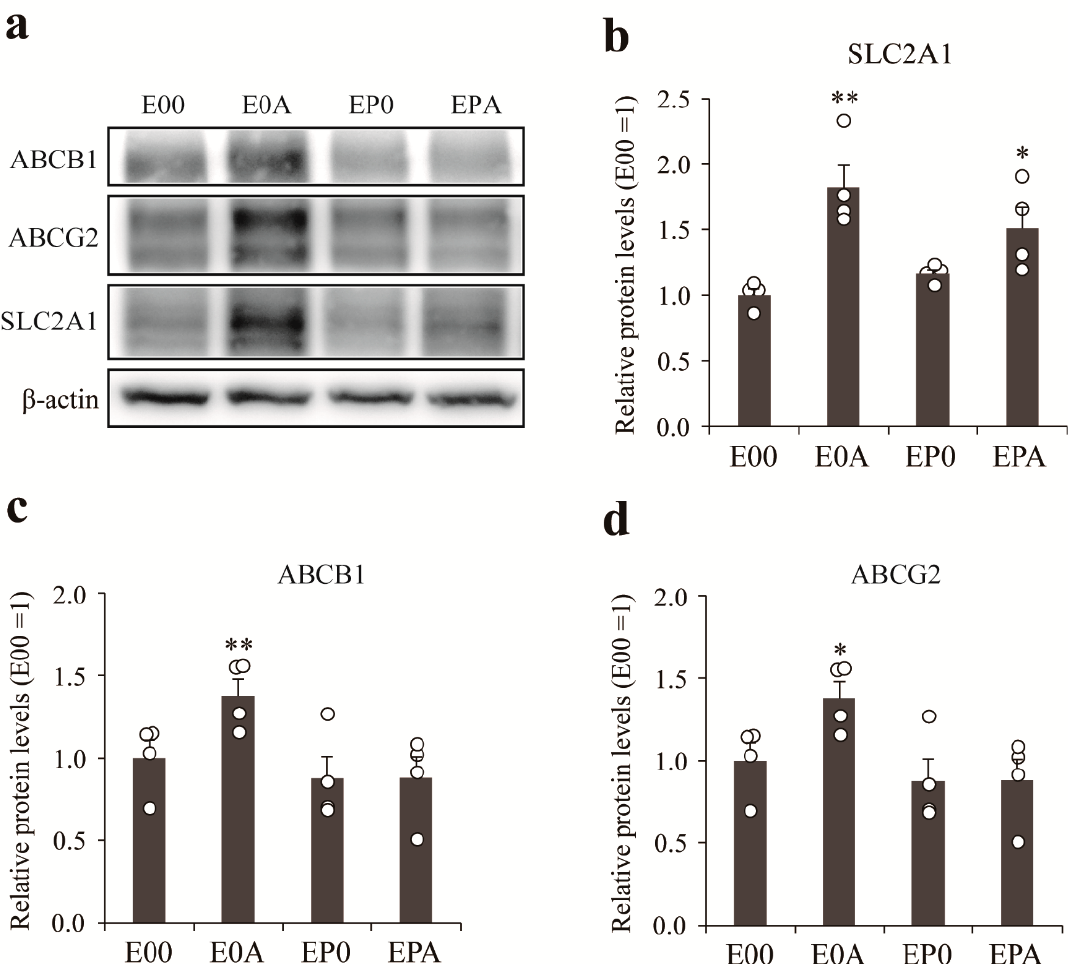
Figure 6. Expression of transporters in different BBB models were determined by western blot. ( a ) Representative image of the western blot. The bar graph reflects the quantitative analysis of the expression levels of SLC2A1 ( b ), ABCB1 ( c ), and ABCG2 ( d ) were determined in the different BBB models. All data are presented as means ± SEM (n = 4, * p < 0.05, ** p < 0.01 vs. E00). Table 2. BBB permeability parameters measured in monkey and rat in vitro models and in mouse in vivo.